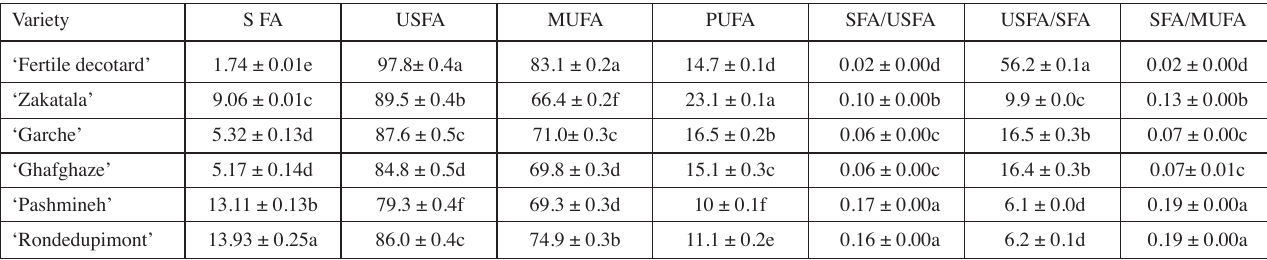
Tab. 3: Summary of the important fatty acid parameters of oil extracted from hazlnuts ( Corylus avellana L.) varieties